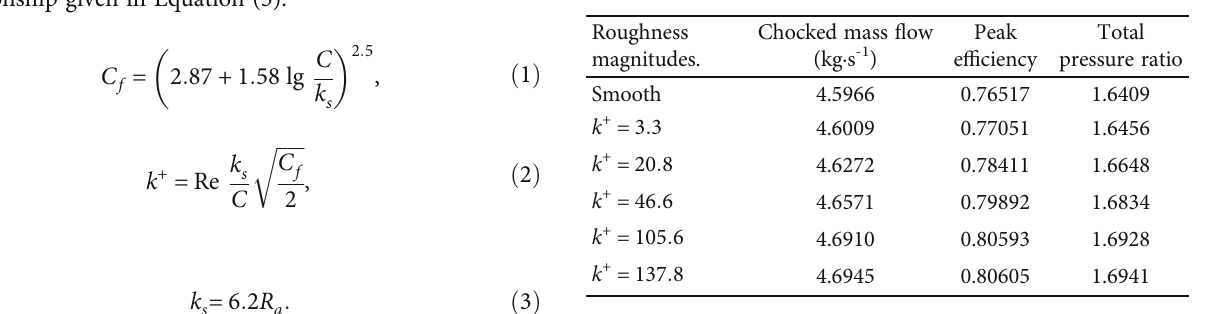
Figure 8: In fl uences of surface roughness on the aerodynamic performance of the compressor. Table 4: Predicted performance parameter of the compressor at typical roughness